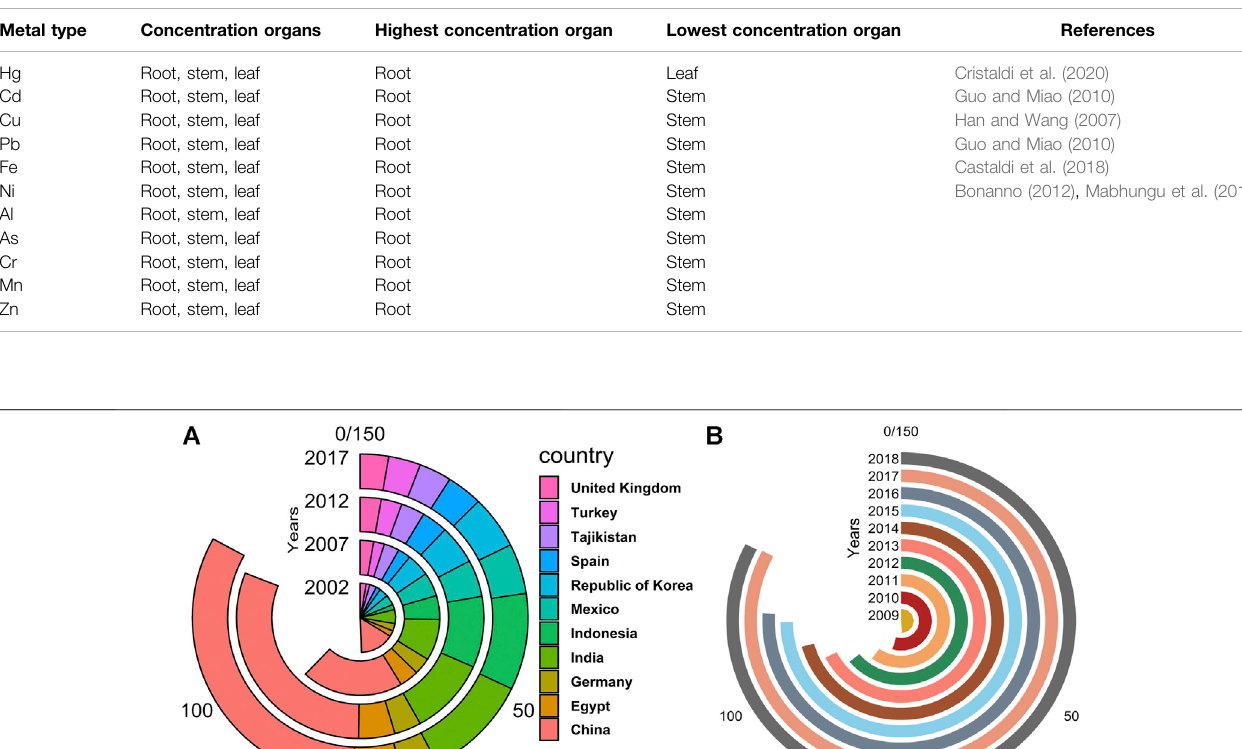
TABLE 1 | Types and locations of giant reed accumulating heavy metals.